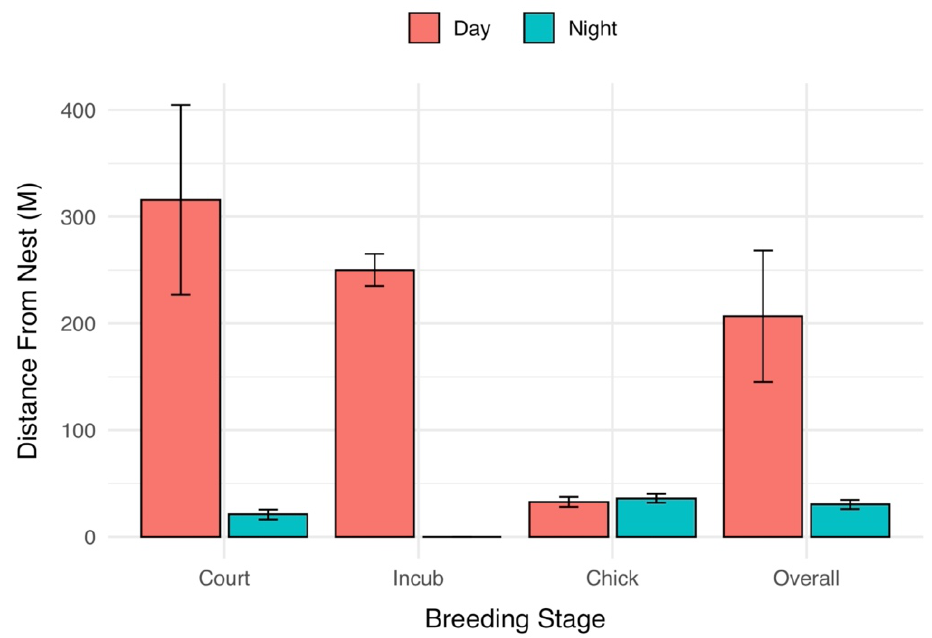
Figure 4. Mean distance from nest location where piping plovers were observed throughout three breeding phases during the 2018 breeding season along Lake Superior, Michigan, USA.